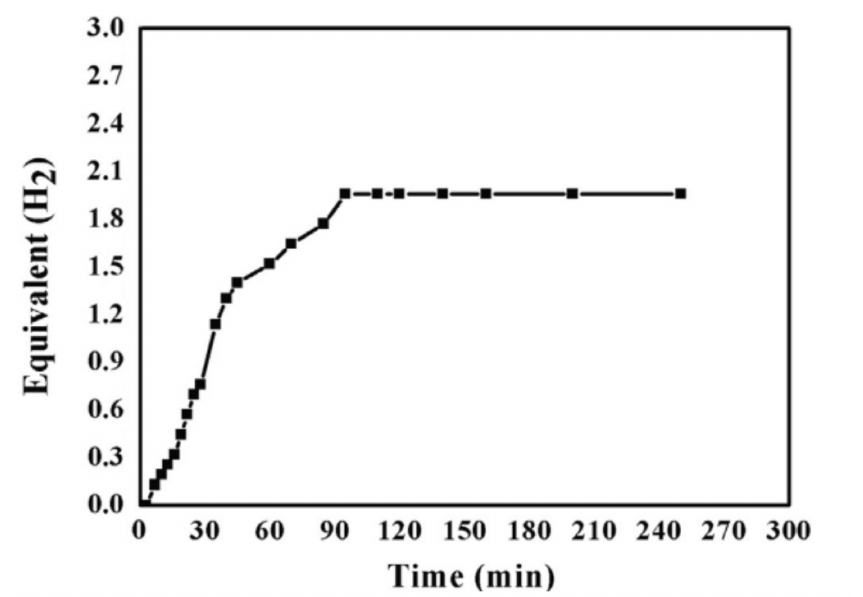
Figure 19. Catalytic performance of Cu-doped TiO 2 carbon nanofibers for AB hydrolysis reaction under sunlight. Reprinted from reference [111] with permission from